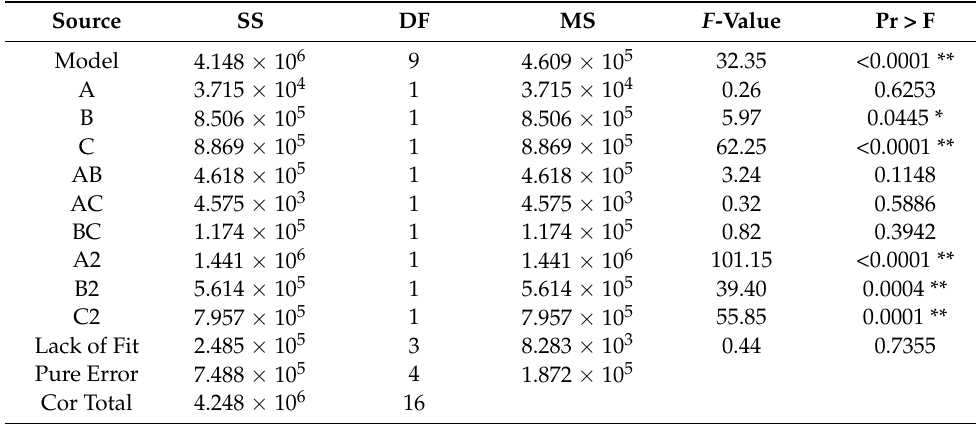
Table 4. Variance analysis of the binary regression